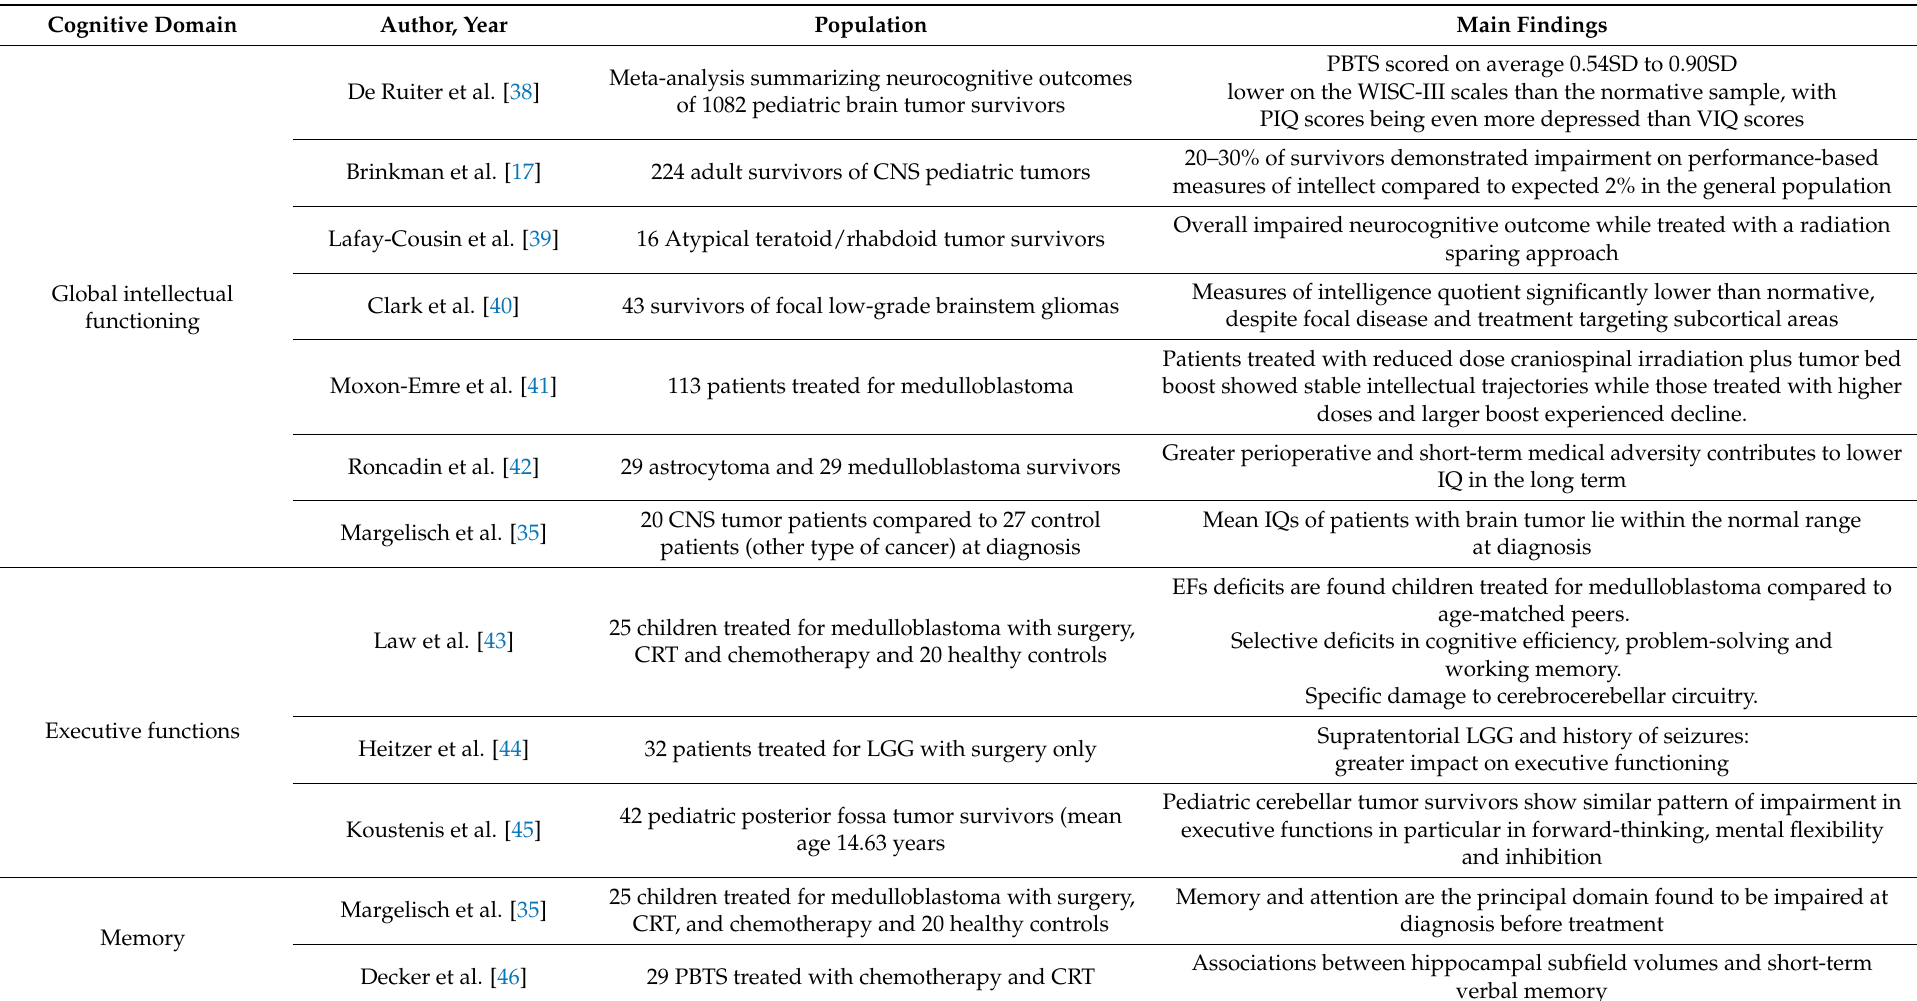
Table 1. Cognitive domains impacted by tumor and its treatment and studies describing characteristics and risk factors of